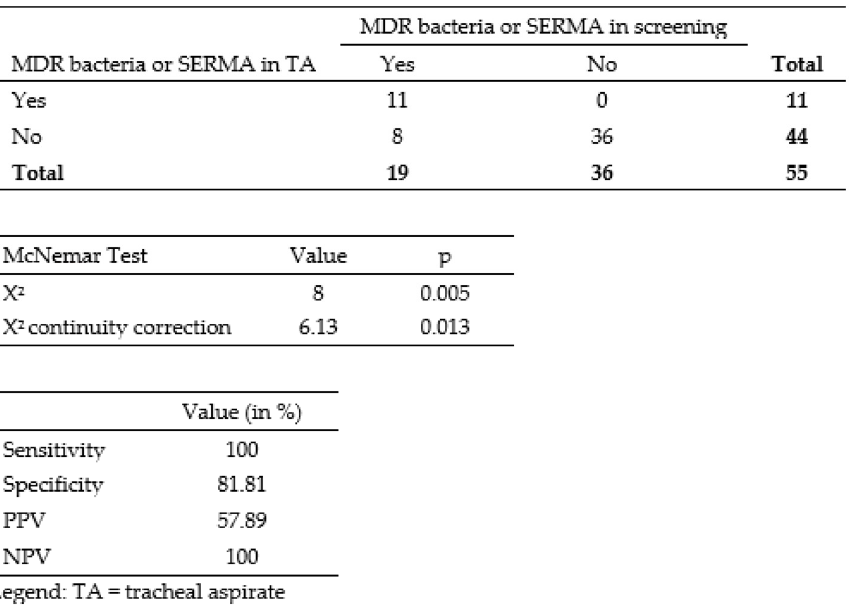
Figure 4. Contingency table with number of patients with MDR bacteria or SERMA in screening and in TA.